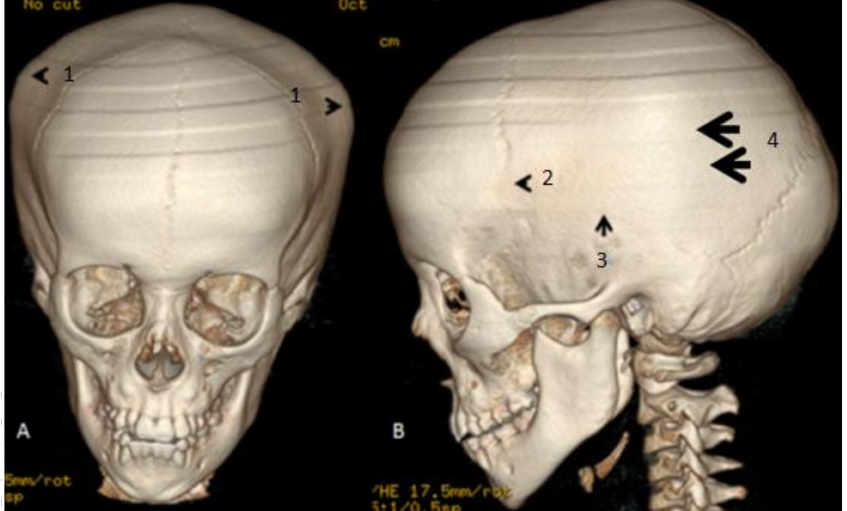
Figure 1. ( A , B ) 3D reconstruction CT scan of the cranium (anterior and lateral views) in the 17-year-old girl showed marked bulging of the frontal area associated with overlapping of the posterior cranial vault because of extreme bulging of the temporal bones (hat-like appearance in connection with extreme bulging of the skull bones over the temporal areas (arrowheads1). Partial closure of the coronal sutures (arrowhead 2) associated with total closure of the squamosal sutures (arrow 3) resulted in the development of bony bulging over the synostosed squamosal sutures. The bony bulge extended over the squamosal suture arches posteriorly from the pterion and connected the temporal squama with the inferior border of the parietal bone (hat-like appearance in the anterior view) (arrowheads 1) and (arrows 4) in the lateral view 4. Note the persistence of the metopic, sagittal, and lambdoid sutures (Figure